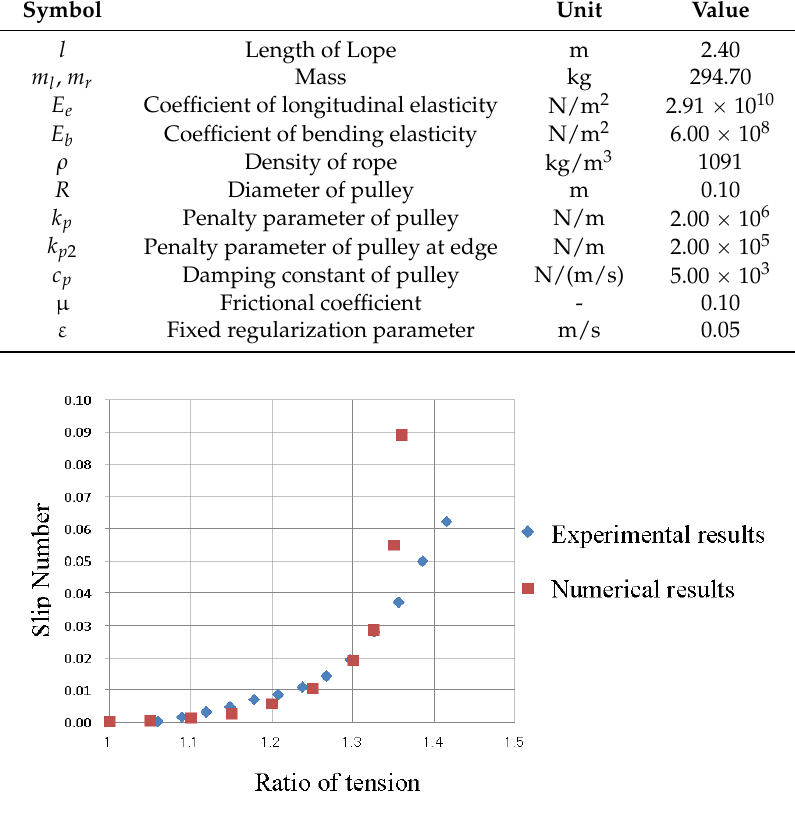
Figure 7. Ratio of tension vs. slip number.